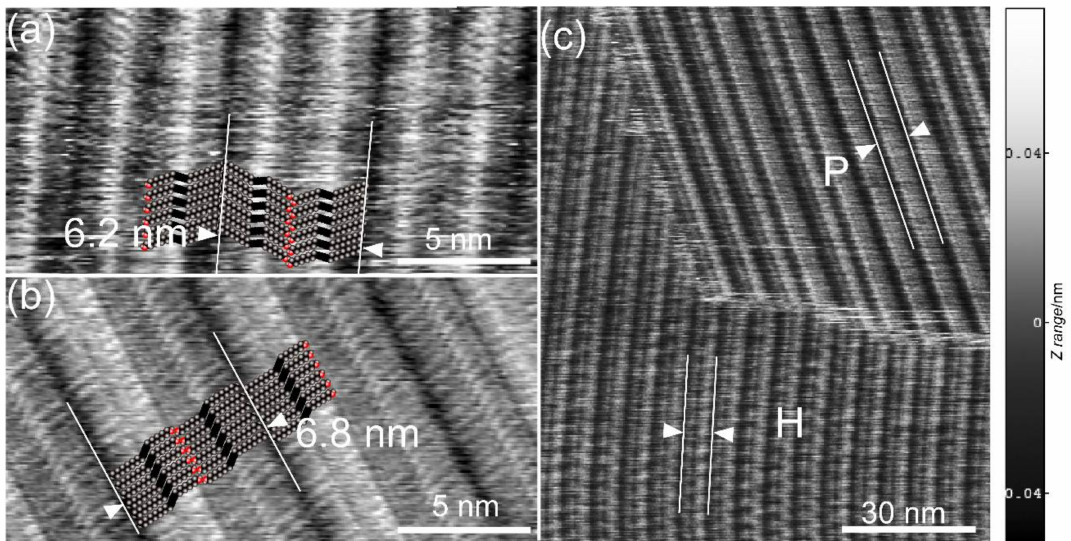
Figure 2. STM height images of a PCDYol monomolecular film formed on a HOPG surface by quasi-LB method. The dimer lengths are suggested by pairs of white lines. High-resolution images of ( a ) H arrangement ( I set = 20 pA, V bias = − 800 mV, 7.5 Hz) and ( b ) P arrangement ( I set = 10 pA, V bias = 800 mV, 8.1 Hz). The adsorption model is superimposed at the bottom. ( c ) A large-area image showing the coexistence of H and P domains ( I set = 10 pA, V bias = − 100 mV, 3.9 Hz). The Z range is presented on the right